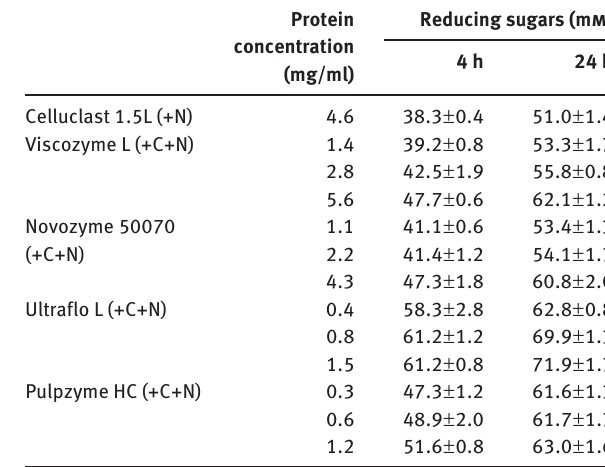
(Table 3); the presence of xylanase, pentosanase and ara-